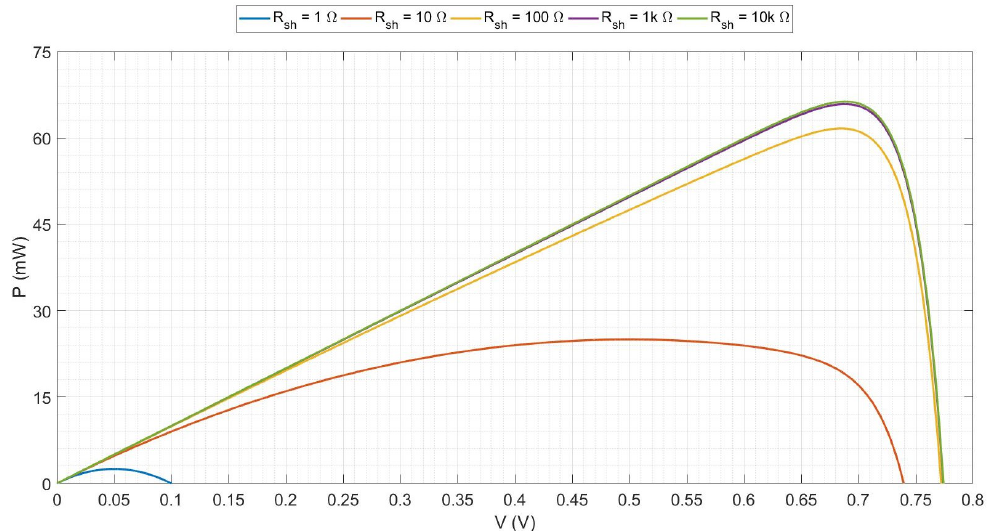
Figure 9. Example of P(V) curves for different values of R sh : the effect of the shunt resistance on the power–voltage